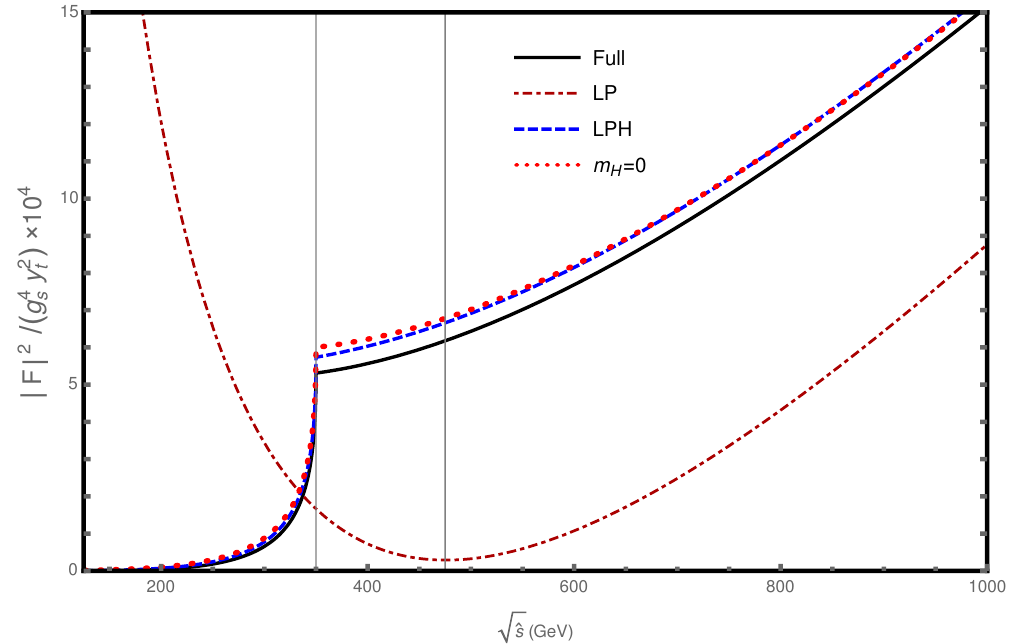
p ^ s : the full form